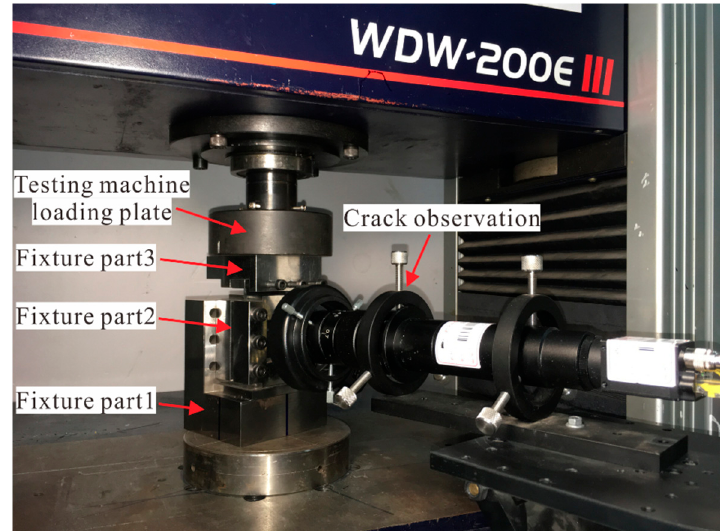
Figure 5. The setup for the compression test of laminates.